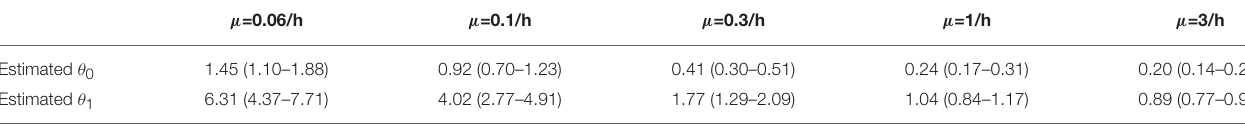
TABLE 3 | Estimated relative entry rates in the DD recruitment model ( θ 0 and θ 1 ) strongly depend on the value of assumed exit rate from the cluster µ . µ